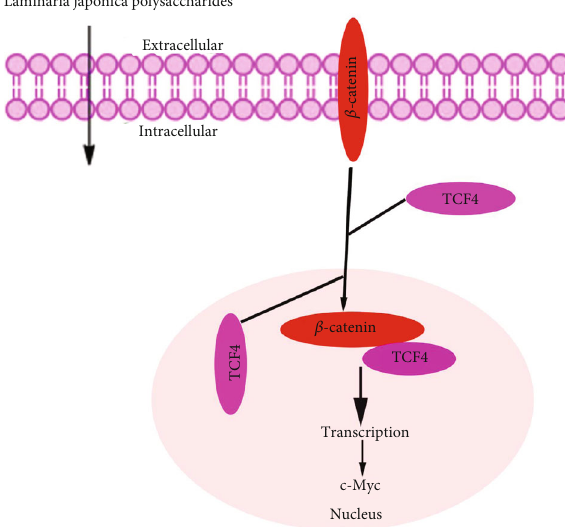
Figure 9: Schema of LJP regulating β -catenin/TCF4 signaling